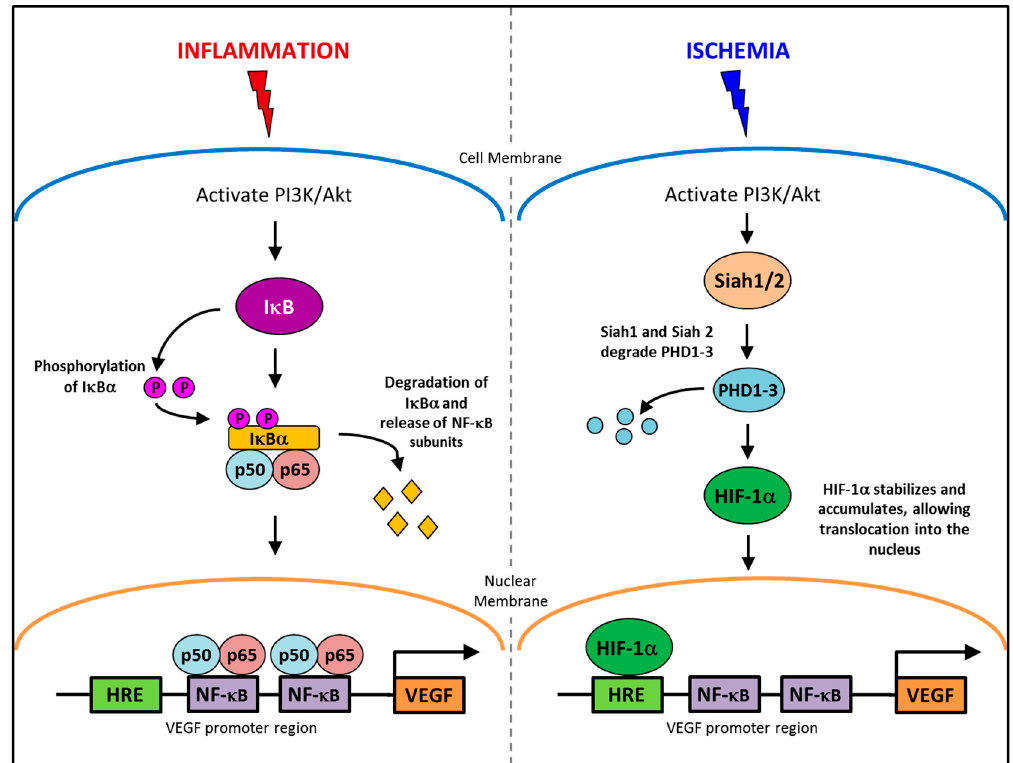
Figure 1. The conditional regulation of vascular endothelial growth factor (VEGF) in inflammation and ischemia. An inflammatory stimulus activates the PI3K/Akt pathway, leading to the phosphorylation of I κ B α . I κ B α is degraded allowing NF- κ B subunits, p50 and p65 to translocate into the nucleus and activate the production of VEGF. Whereas, ischemia activates the PI3K/Akt pathway to increase the production of Siah1 and Siah2, causing the degradation of PHD1-3 preventing the targeted degradation of HIF-1 α , allowing it to accumulate and then translocate to the nucleus where it upregulates VEGF